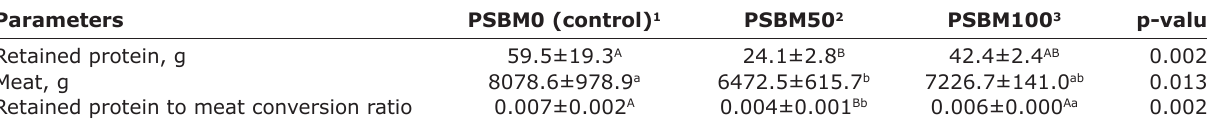
Table-3: Retained protein to meat conversion ratio.